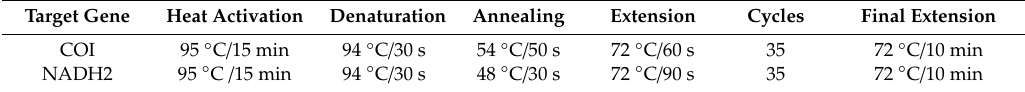
Table 2. COI and NADH2 amplification